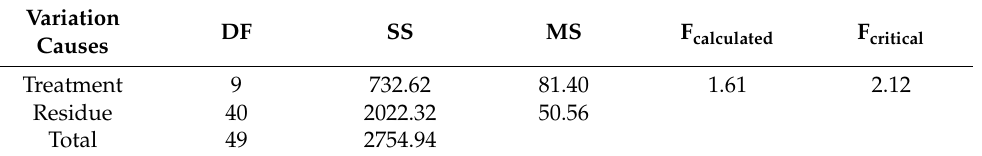
Table 6. ANOVA for maximum tensile strength of TVFs for different diameters.